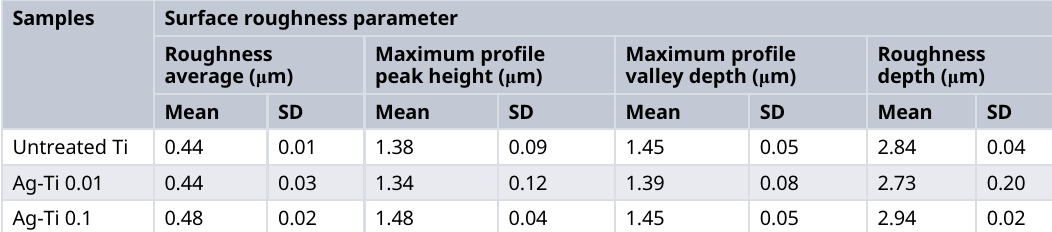
Table 1. Surface roughness parameter obtained from roughness tester. The values were calculated from three independent samples. 16